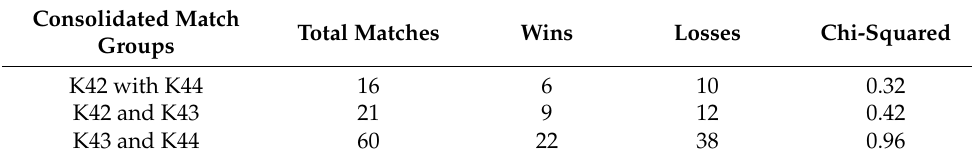
Table 3. Results of Chi-squared analysis for the consolidated